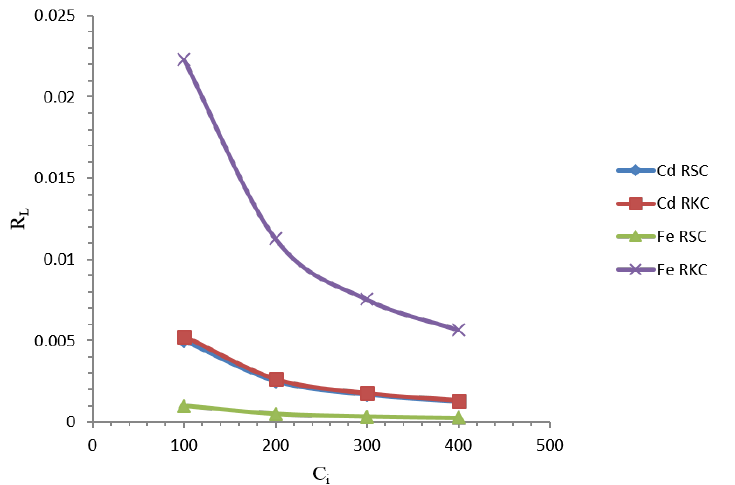
: Cd RSC-Cadmium L